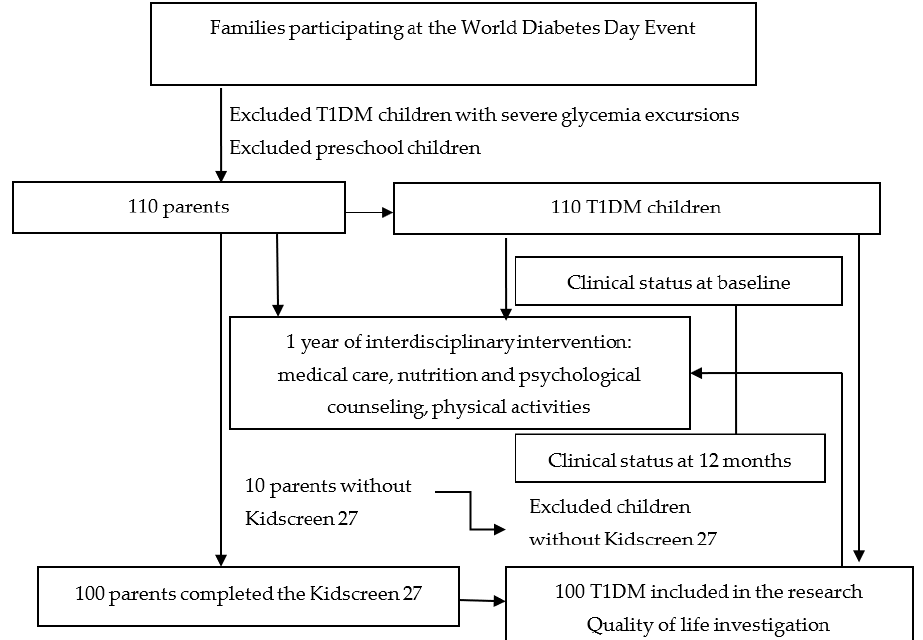
Figure 1. Research protocol flowchart.